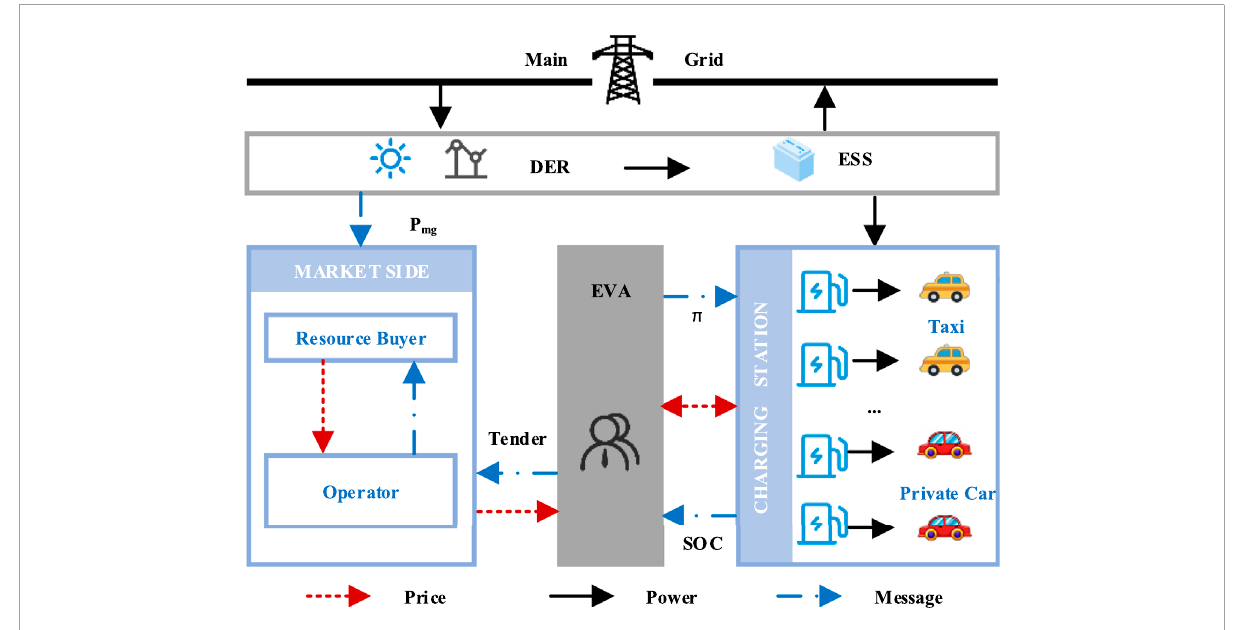
FIGURE 1 Scheduling framework of the EV charging station in a